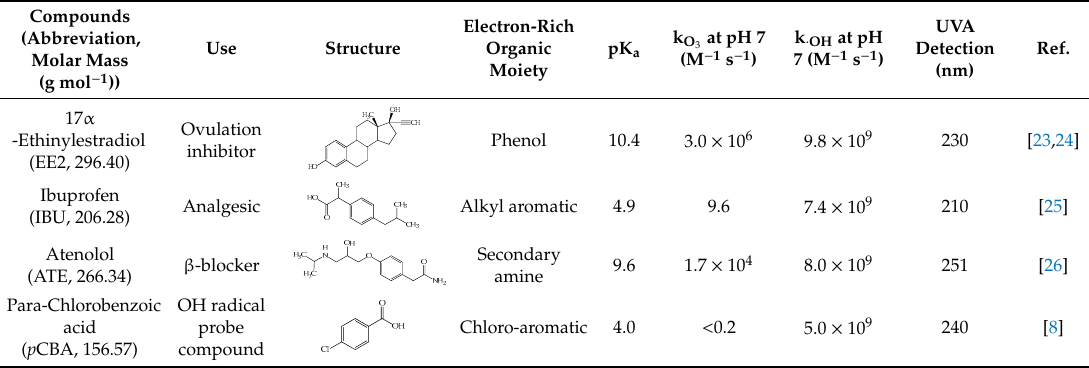
Table 1. The second order rate constants for the reactions of the target pharmaceutical compounds with O 3 at pH 7 and OH radicals.